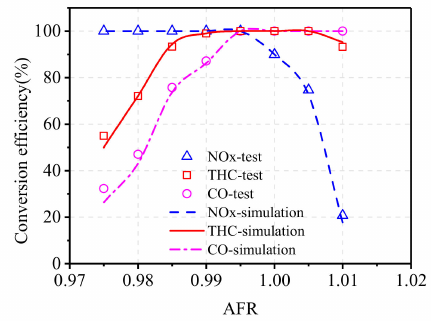
Figure 4. Comparison of simulation results and test results of catalytic conversion e ffi